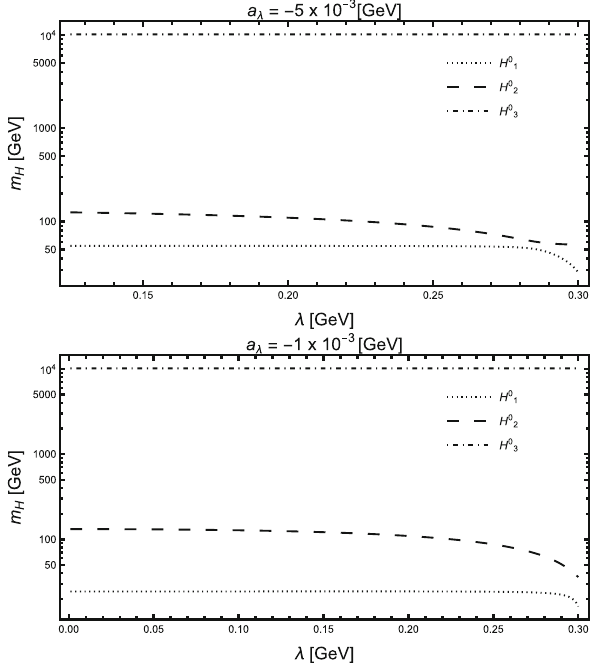
Fig. 3 Mass values of the CP-even sector Higgs bosons as a function of the scalar potential parameters λ for two values of a λ . Here we have chosen tan β = 30, g Z (cid:2) = g Y , v S = 2 × 10 4 GeV, and v 2 = 246